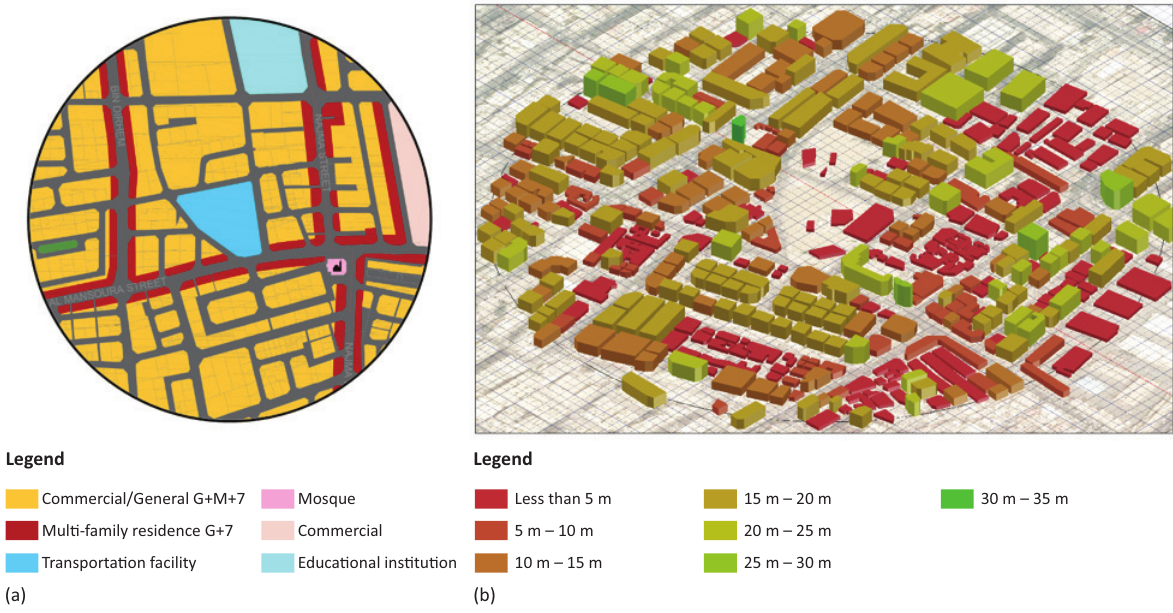
Figure 7. The surroundings within a 400 m radius: (a) Land use within 400 m of the metro station and (b) building heights within 400 m of the metro station.